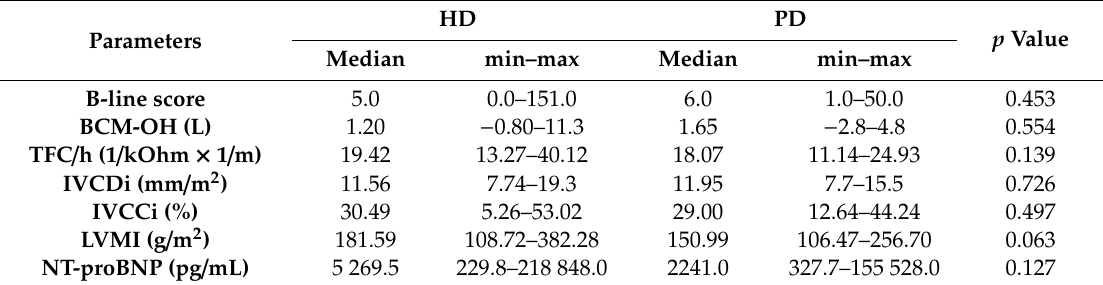
Table 10. Comparison of the results of select studies that objectify the clinical assessment of